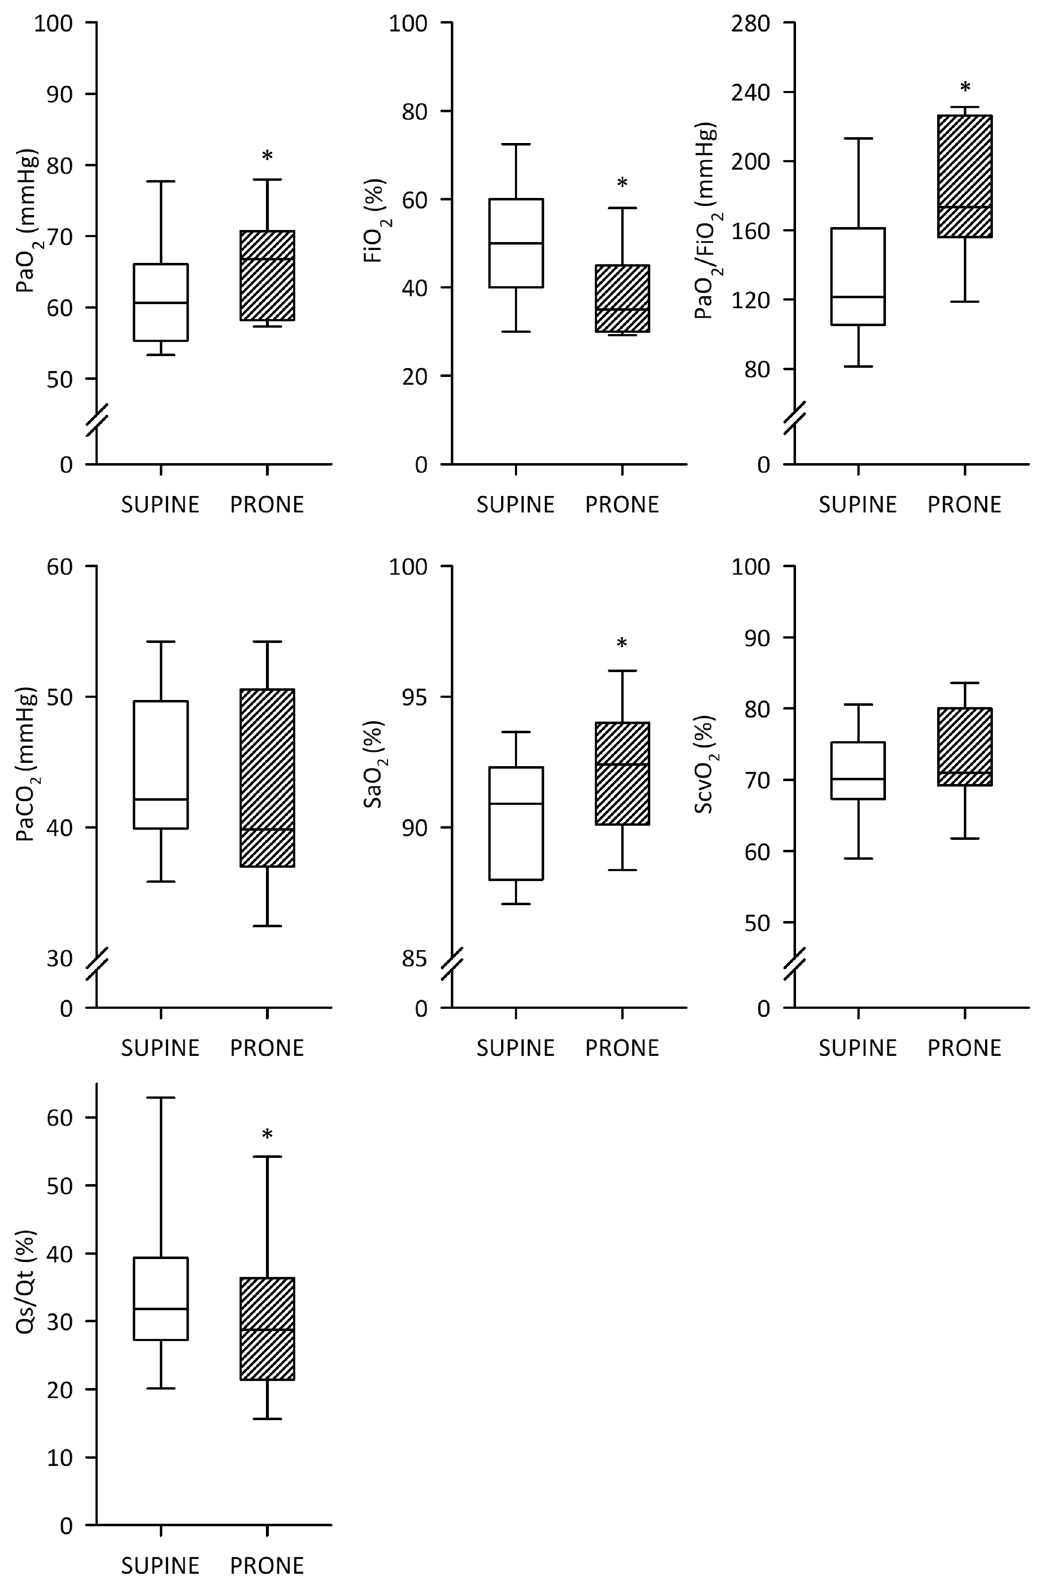
Figure 4. Blood gas and oxygenation data for intubated patients in supine and prone positions. Partial pressure of oxygen in the arterial blood (PaO 2 ), fraction of inspired oxygen (FiO 2 ), partial pressure of carbon dioxide in the arterial blood (PaO 2 ), arterial oxygen saturation (SaO 2 ), central venous saturation (ScvO 2 ), intrapulmonary shunt fraction (Qs/Qt). Empty boxes indicate data acquired in prone position; boxes with diagonal line pattern indicate data acquired supine position. *: p < 0.05 versus supine